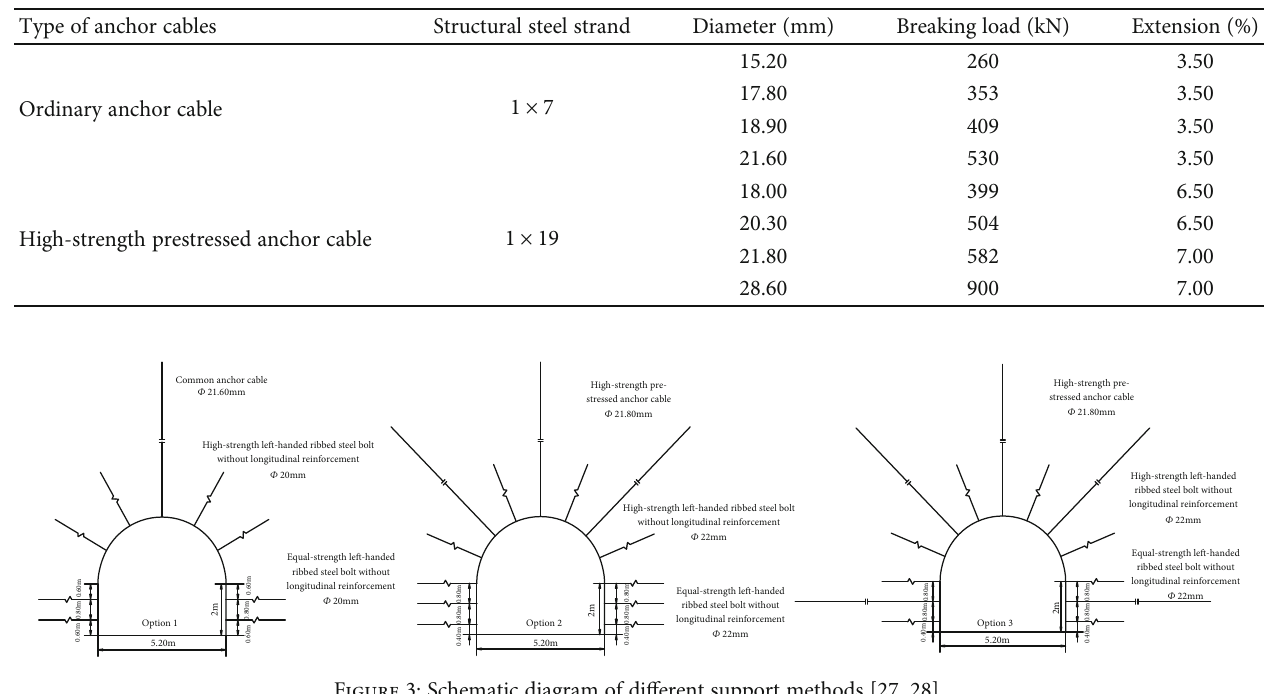
Figure 2: Schematic diagram of the anchor cable structure Table 2: Mechanical properties of anchor cable materials [25, 26].